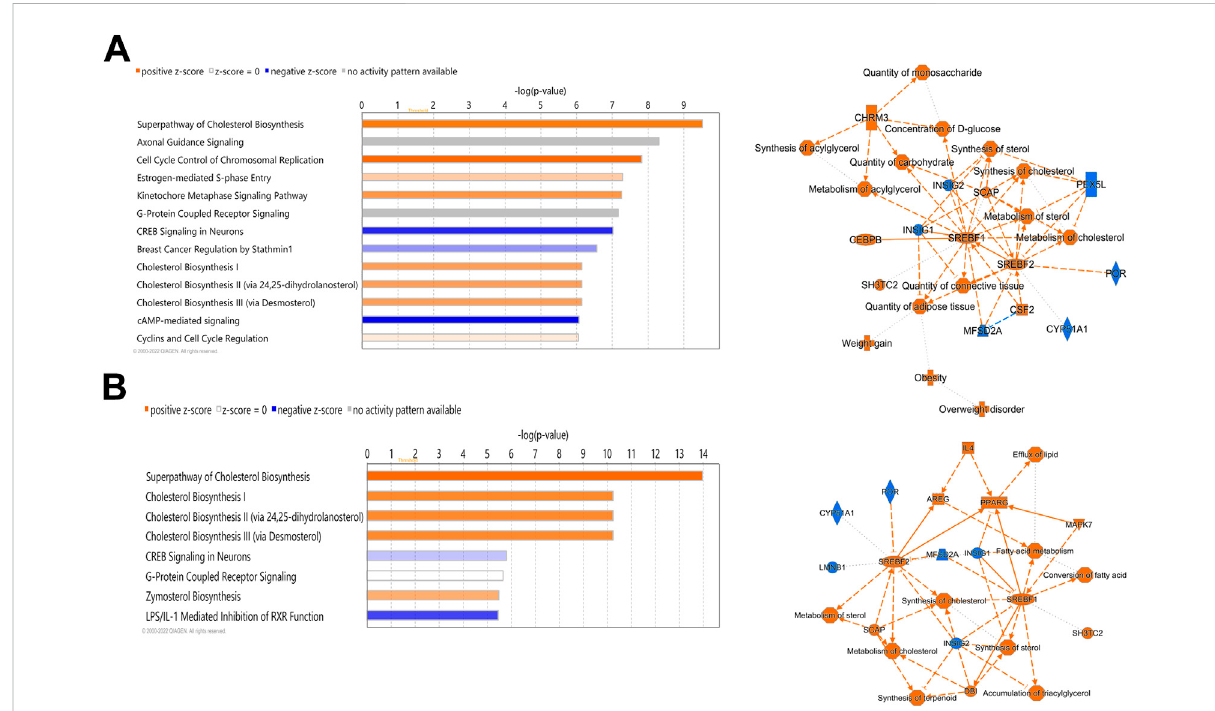
Canonical pathways of differentially expressed hepatic genes between FED chicks and E18 embryos. (A) Genes with a fold-change ≥ 2; FDR p -value ≤ 0.05and (B) Geneswithafold-change ≥ 5;FDR p -value ≤ 0.05.Orangeindicatesapositivez-score;expressionpatternsofmemberspredicts activation of the pathway. Blue indicates a negative z-score; expression patterns of members predicts inhibition of the pathway.